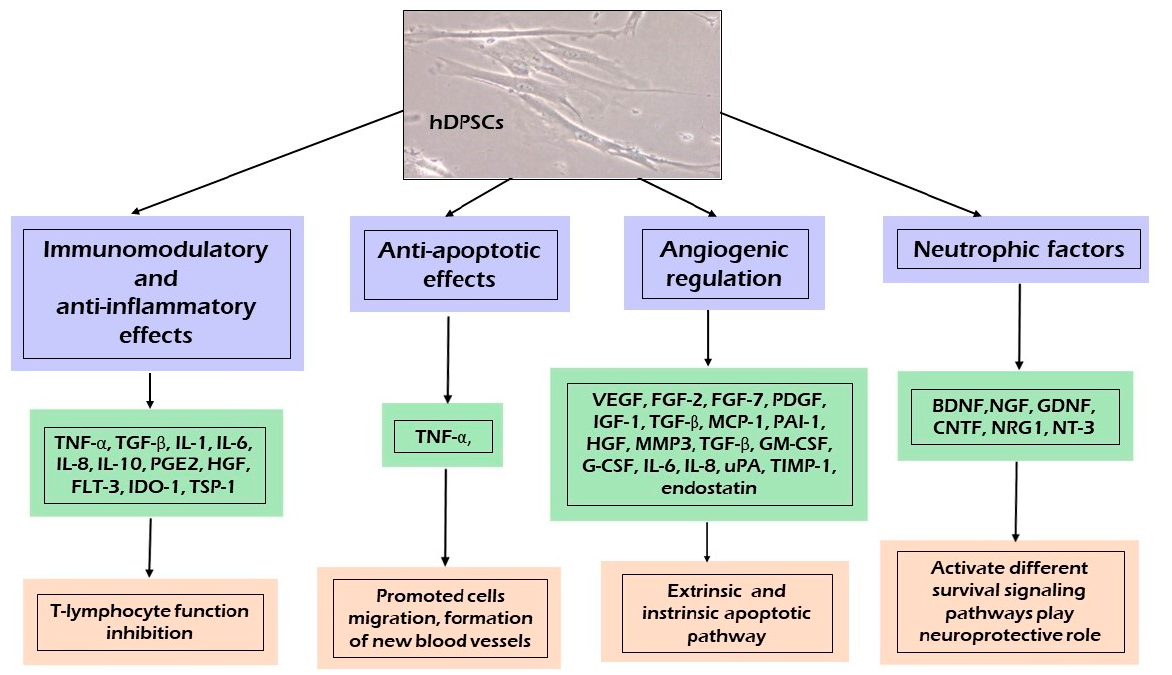
Figure 3. Paracrine effect induced by human dental pulp stem cells (hDPSCs) secretome.